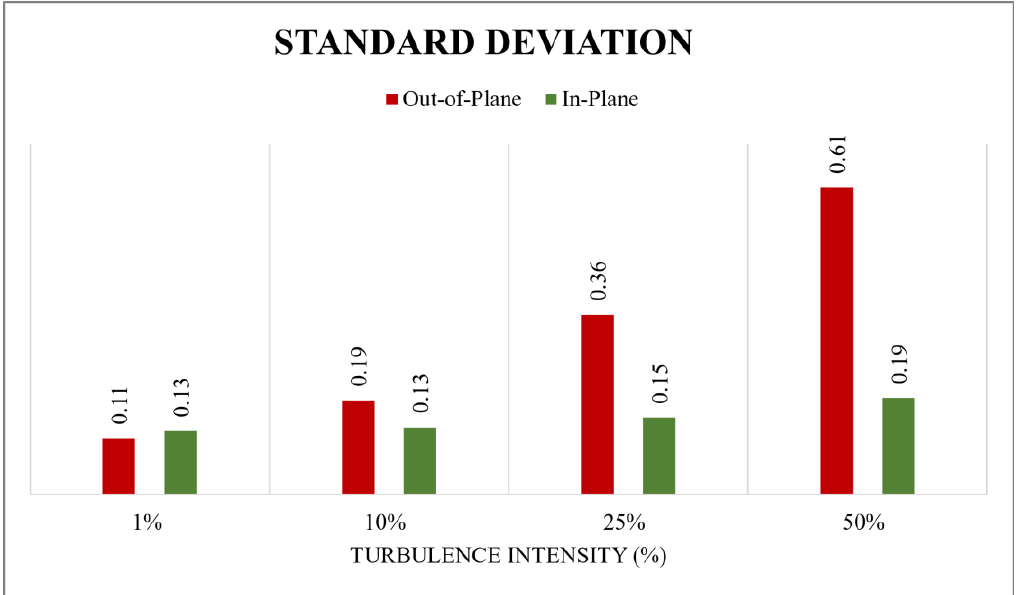
Figure 16. Standard Deviation of the Blade Deflections